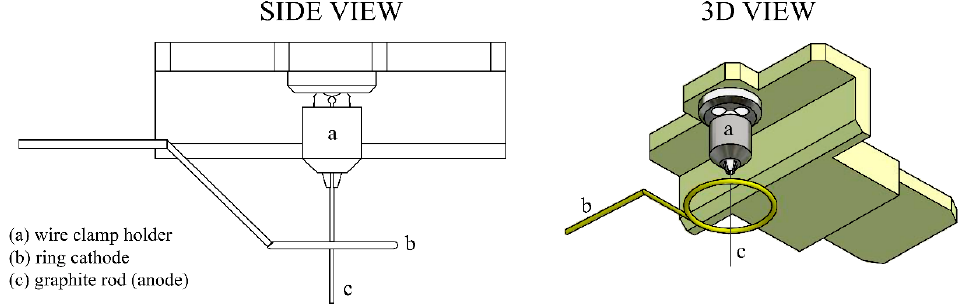
Figure 2. A precise clamp holder extension intended for 0.2–0.4 mm diameter wires’ perpendicular fixation toward the electrolyte surface.